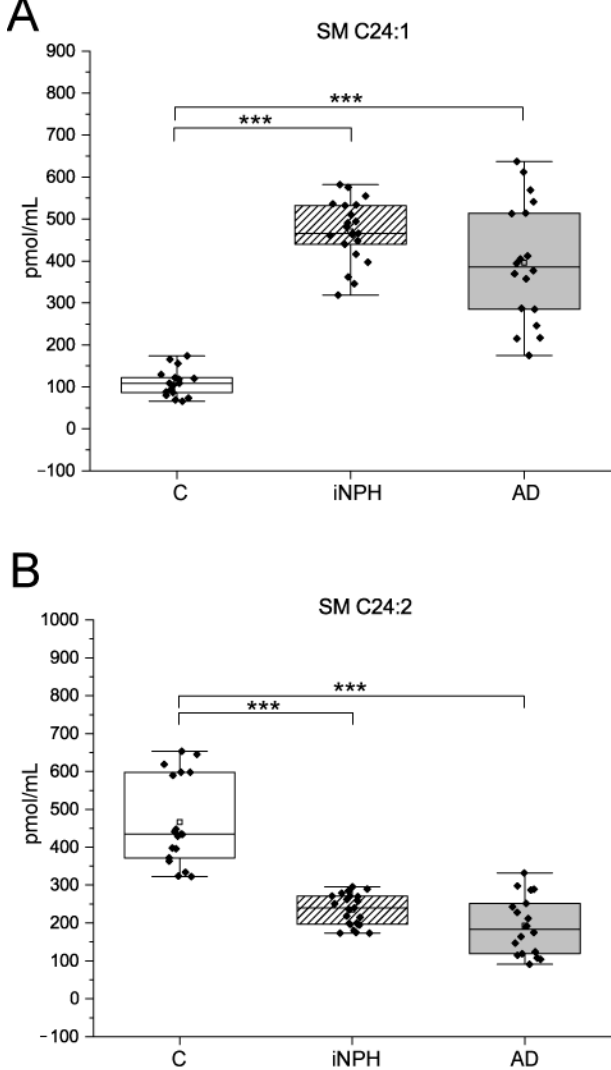
Figure 3. Box plots of ( A ) SM C24:1 and ( B ) SM C24:2 levels in CSF from iNPH and AD patients compared to C subjects. Each measurement was run in triplicate. Data were analyzed using Kruskal–Wallis ANOVA, followed by Dunn’s post hoc test for multiple comparisons. *** p -value <